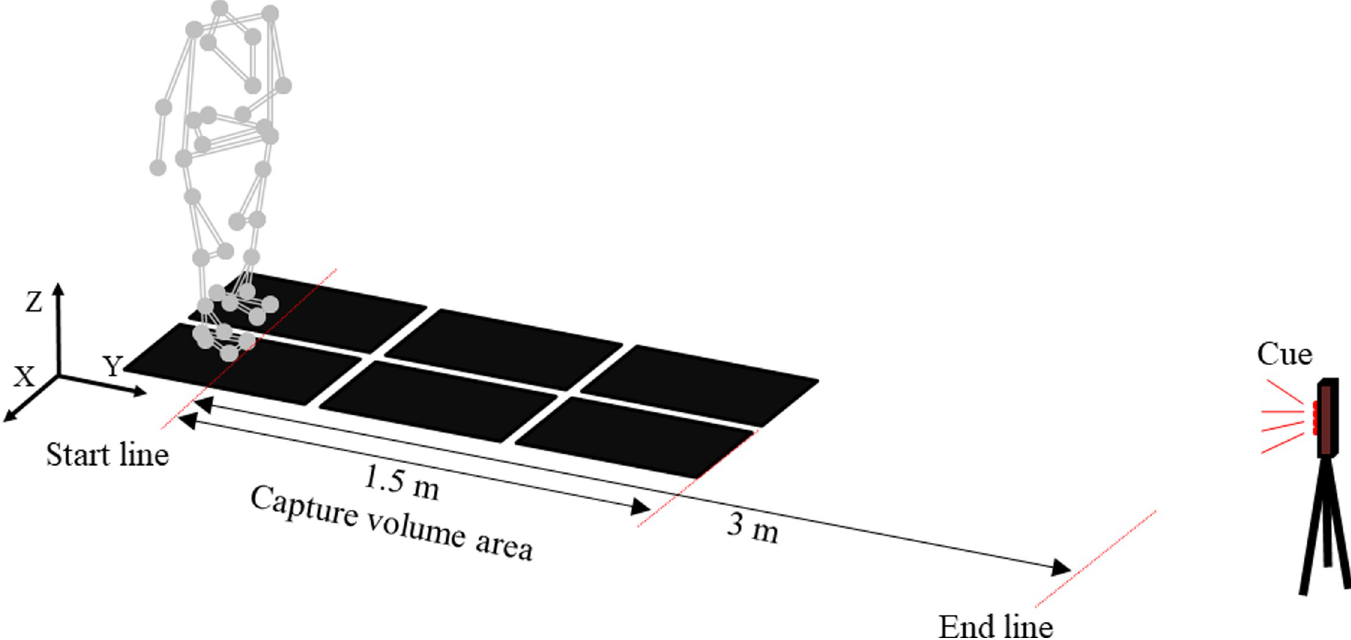
Fig 1. Experimental set-up for GI with 34 reflective markers and 6 force